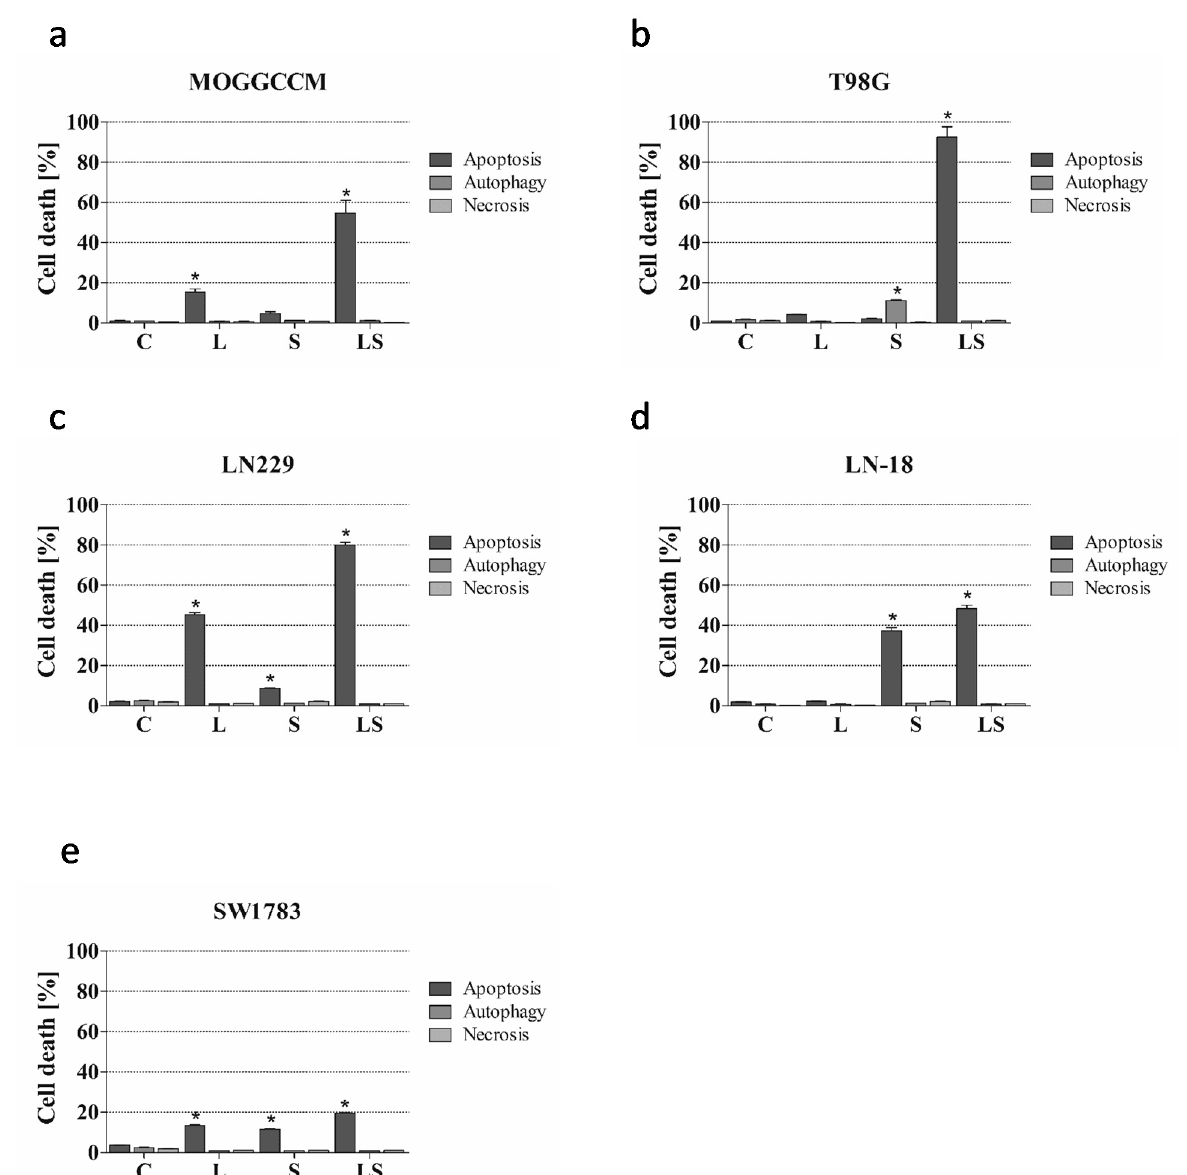
Figure 3. Effect of lensoside A β (L) and sorafenib (S) applied alone and in combination (LS) on the level of apoptosis, autophagy, and necrosis, identified microscopically after staining with Hoechst 33342, acridine orange, and propidium iodide, respectively, in anaplastic astrocytoma (MOGGCCM, LN229, SW1783; ( a , c , e )) and glioblastoma multiforme cells (T98G, LN-18; ( b , d )) incubated with the compound for 24 h. C—control; * p < 0.01 compared to the control.